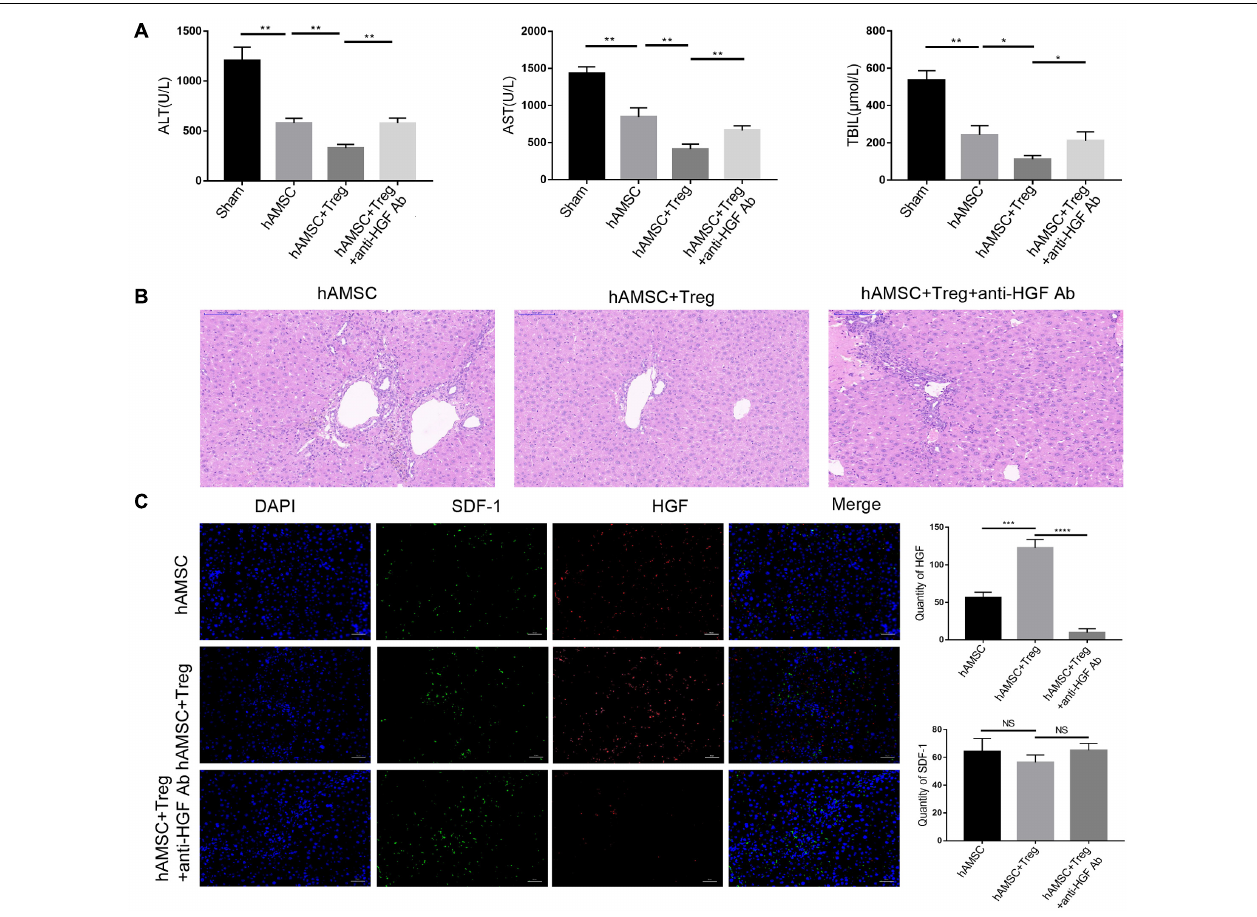
FIGURE 3 | PBS, hAMSC, hAMSC + Treg, and hAMSC + Treg + anti-HGF Ab were injected into mice through the tail vein, respectively. (A) Level of ALT, AST, and TBIL of four groups. (B) Representative images of liver tissue [hematoxylin and eosin (HE) staining] by light microscopy in three groups. (C) Representative fluorescent images for SDF-1 and HGF in three groups were visualized by fluorescence microscopy, and DAPI was used to mark nuclei. The result is representative of three independent experiments. Data were mean ± SD of three independent experiments. * p < 0.05, ** p < 0.01, *** p <